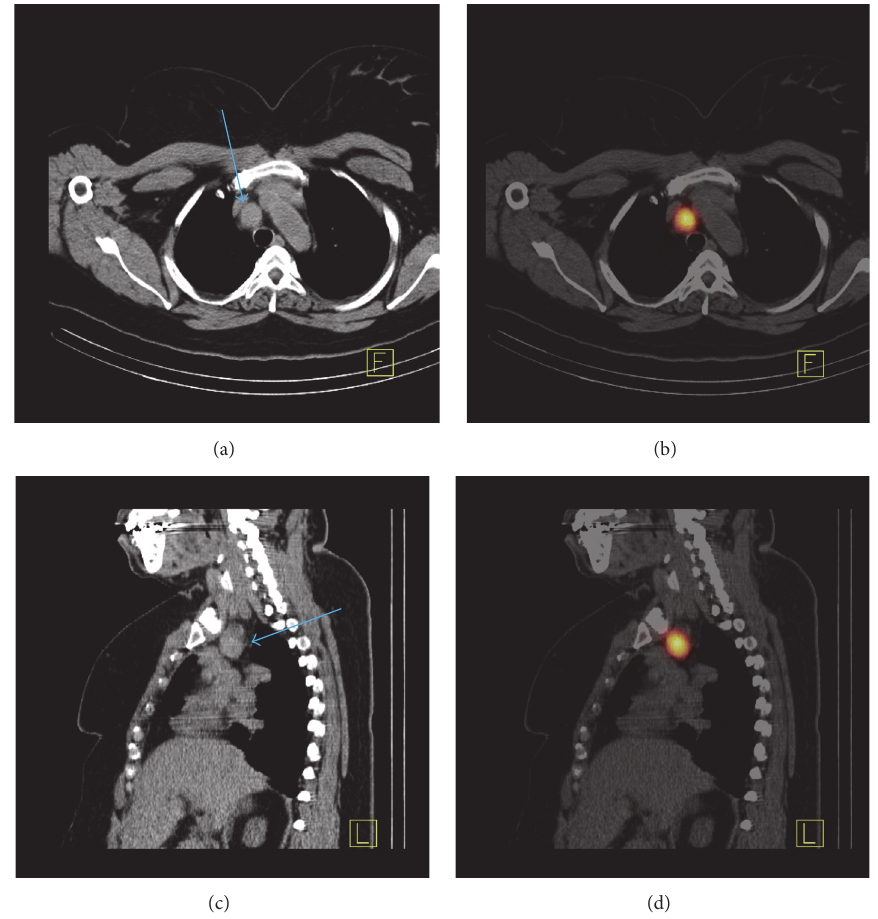
Figure 3: Functional and anatomic imaging of ectopic thyroid tissue in the upper mediastinum by I-123 SPECT/CT. A 2.0 × 1.7cm right paratracheal mediastinal mass was visualized on the axial (a) and sagittal (c) view images of noncontrast enhanced low dose CT component of I-123 SPECT/CT as indicated by a blue arrow. On the axial (b) and sagittal (d) view images of coregistered I-123 SPECT/CT images, I- 123 radioiodine uptake by the right paratracheal mass was visualized as indicated by orange color presentation of I-123 radioiodine activity. The findings of I-123 SPECT/CT further confirmed that the upper mediastinal mass seen on the CTA images represented functional ectopic thyroid tissue, consistent with the results of histological analysis of the tissue samples obtained by endobronchial ultrasound-guided